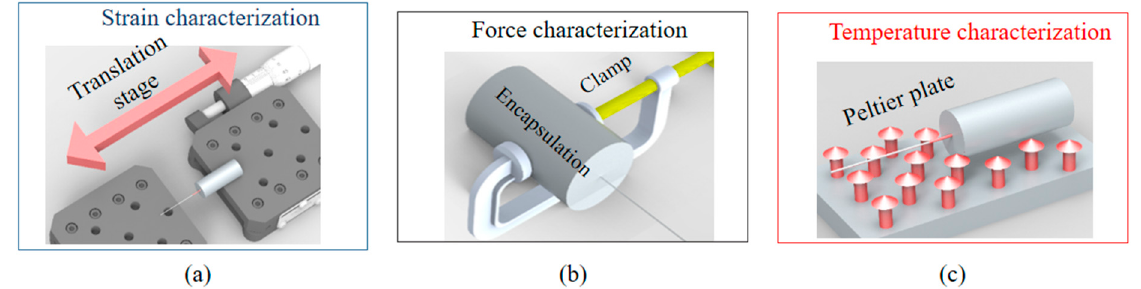
Figure 4. Experimental setup for the half-embedded TPU structure in the tests of ( a ) strain, ( b ) transverse force and ( c ) temperature.